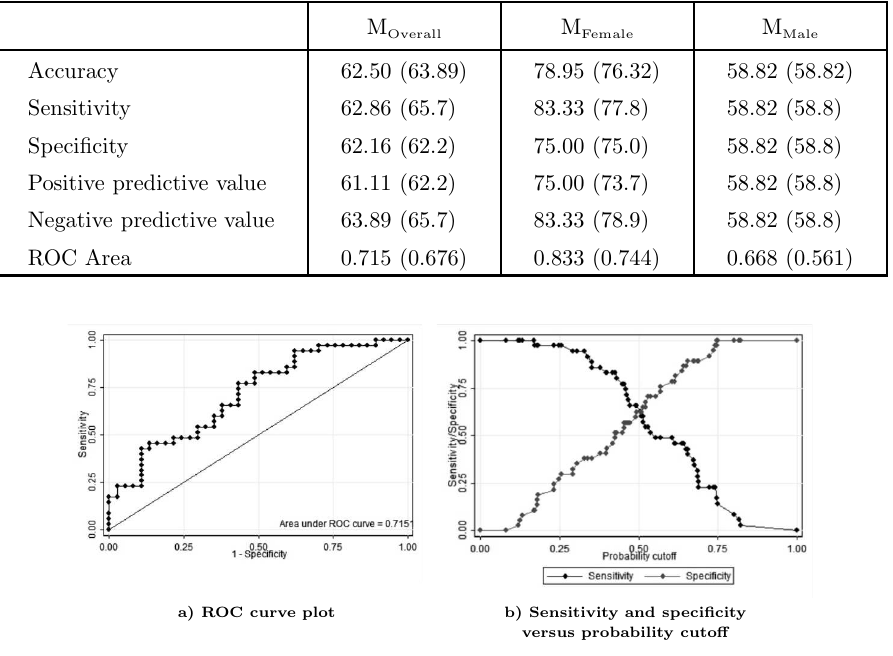
Figure 3. Classification quality assessment Table 13. Results of the logistic regression approach for the female